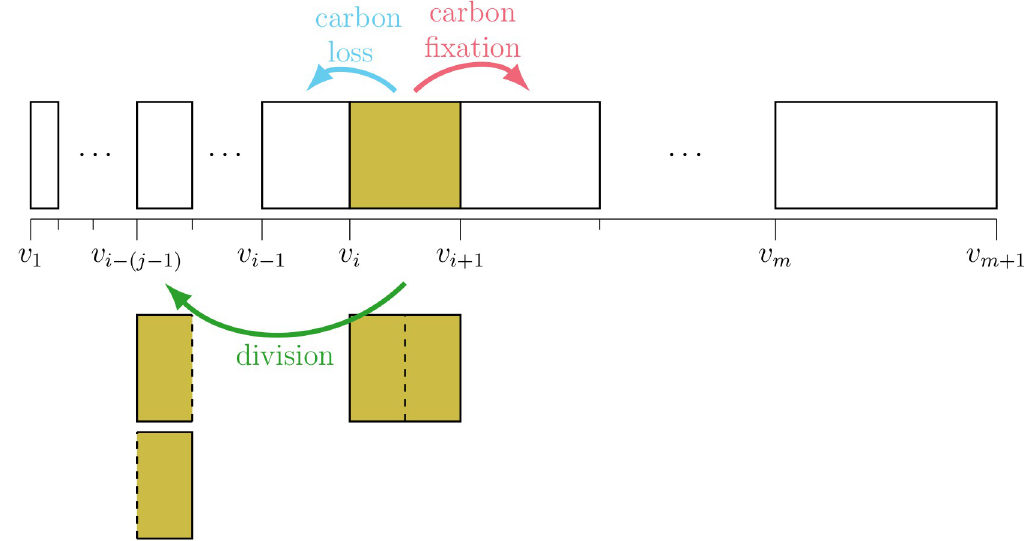
Fig 1. MPM size classes and transitions. Schematic of the MPM’s cell size classes and its three class transitions: carbon fixation, division, and carbon loss. The boundaries of the m cell size classes ( v i for i = 1, 2, ... , m + 1) are logarithmically spaced, so that cells can transition to a size class that is exactly half their original size when they divide. For this purpose, the integer j is selected so that